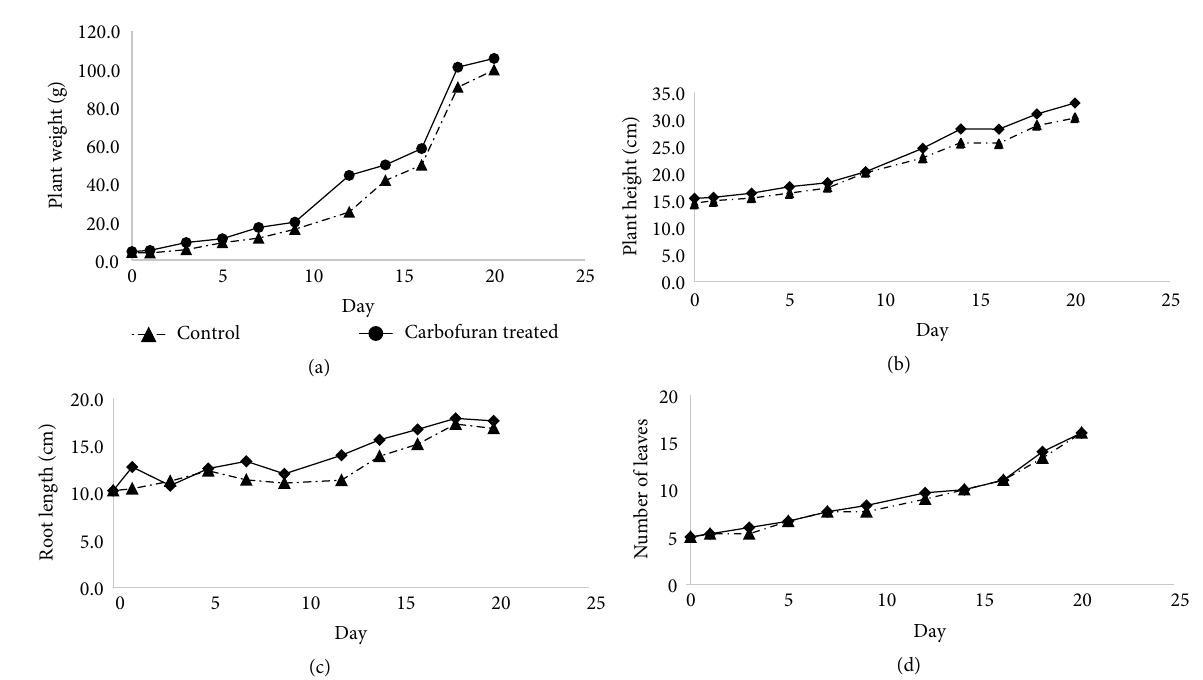
Figure 2: The growth performance of Chinese kale, treated with and without carbofuran. (a) Weight, (b) height, (c) root length, and (d) number of